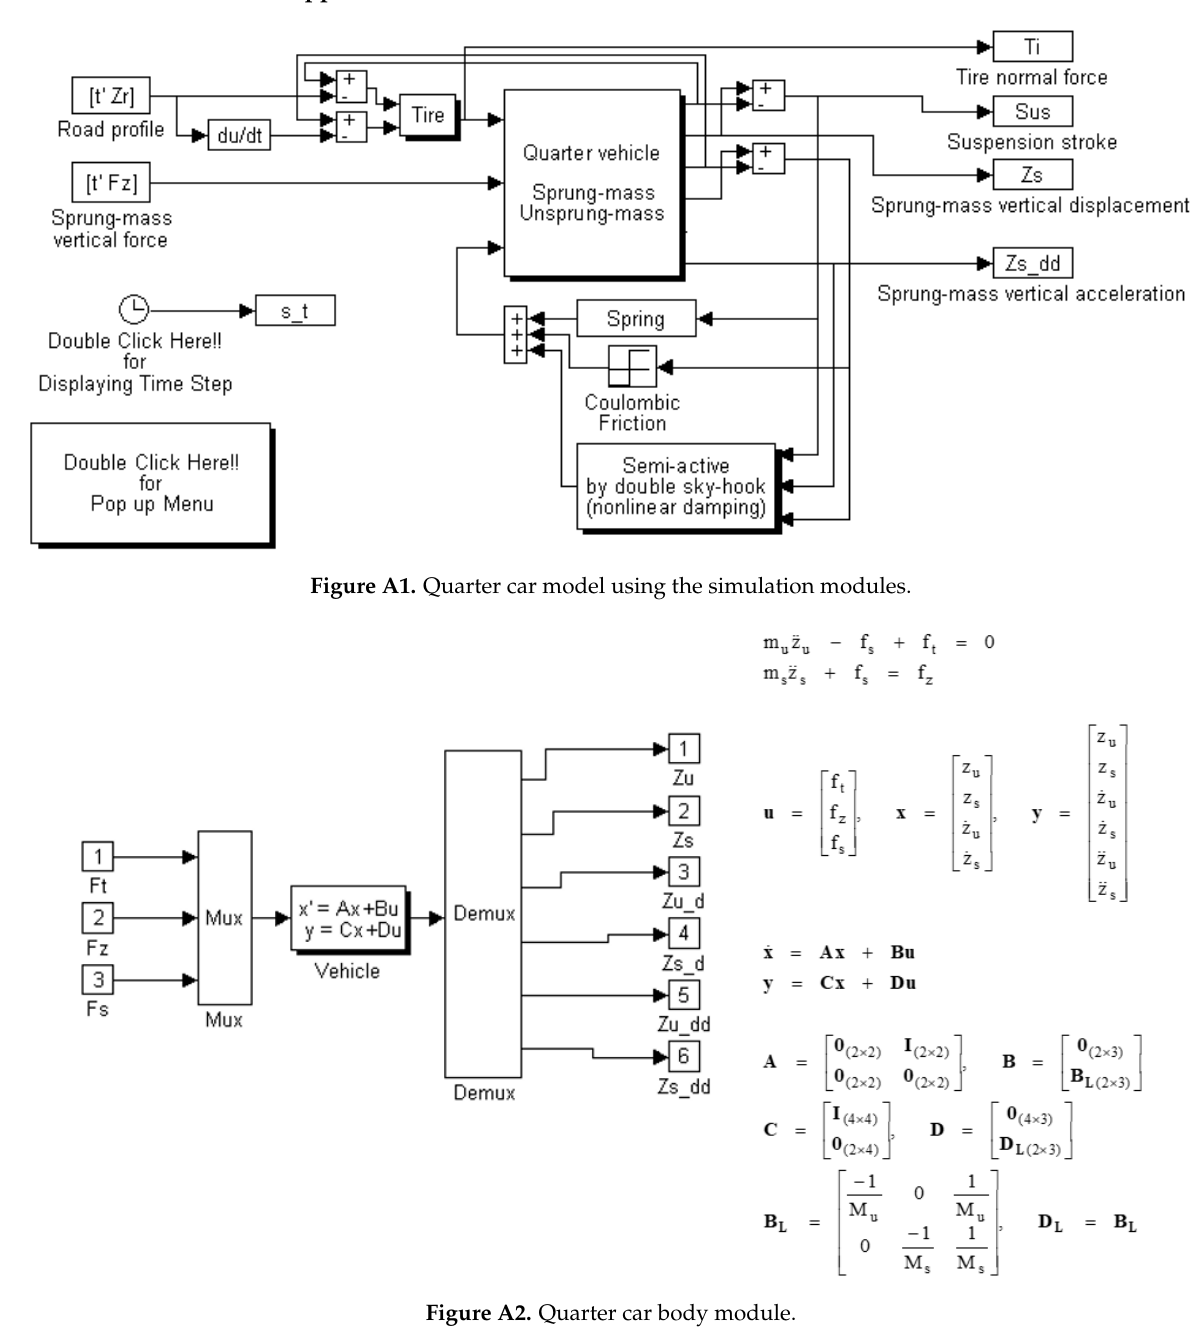
Figure A2. Quarter car body module.